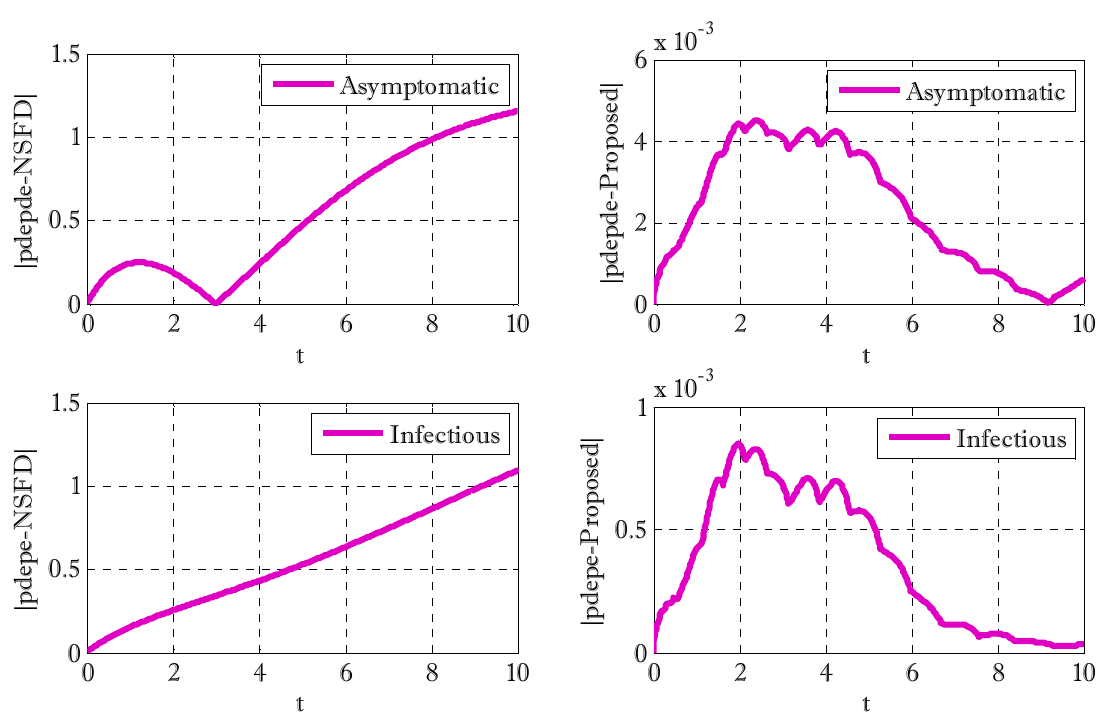
Figure 2. Two-dimensional comparison of proposed and NSFD schemes for asymptomatic and infectious individuals using L = 10, N x = 50, N t = 700, α 1 = 0.5, β = 0.3, γ = 0.4, σ = 0.1, µ = 0.1, d 1 = d 2 = d 3 = d 4 = d 5 = 0.9, α = 1 .